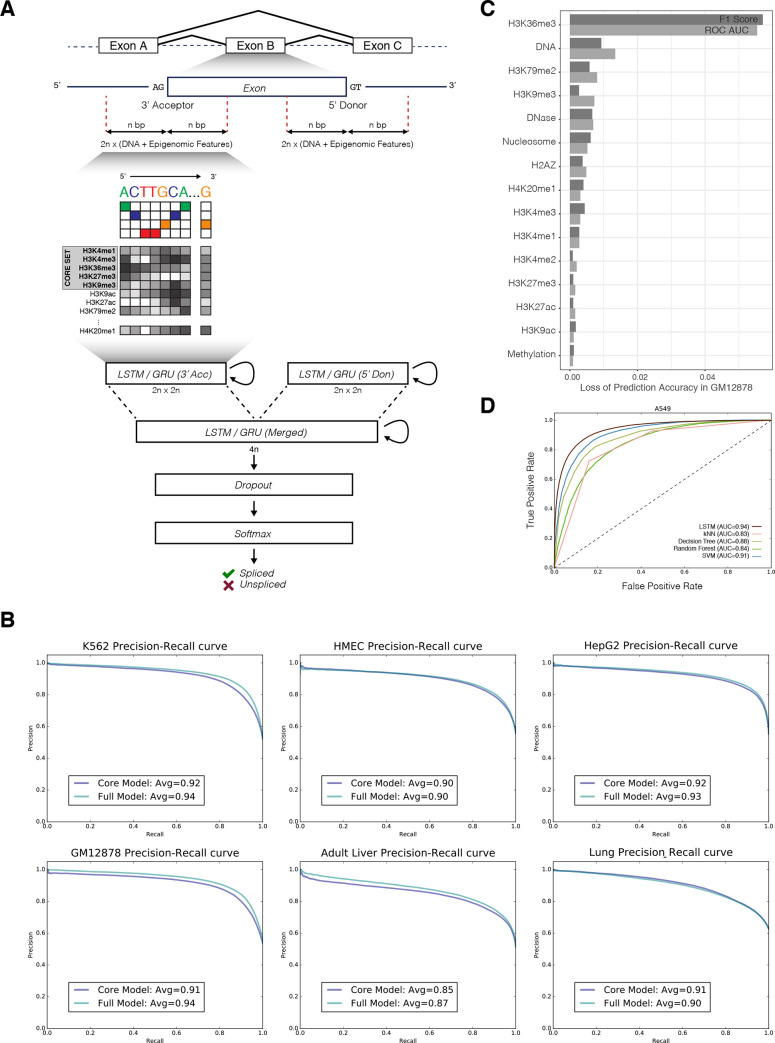
(A) Overview of the ESPRNN model. The model is composed of two recurrent layers. Inputs from 3’ and 5’ SSs are separately processed in the first recurrent layer and then merged in the next recurrent layer. A softmax classifier is used to determine the inclusion of the exon. Using genomic sequences and epigenomic contexts as input, the alternative usage of the exon is predicted. (B) Precision-recall curves from six different ENCODE cell types. (C) Epigenetic features that contribute to splicing regulation. The order and magnitude of importance was determined using leave-one-out analysis and loss of the ROC AUC was calculated when training the model lacking a particular feature. (D) Comparison of LSTM model with other models based on k-nearest neighbor, support vector machine, decision tree, and random forest algorithms.